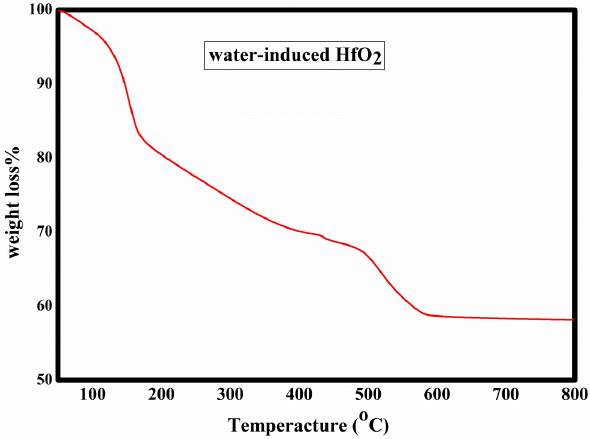
Figure 5. Thermal behavior of HfO 2 xerogel.